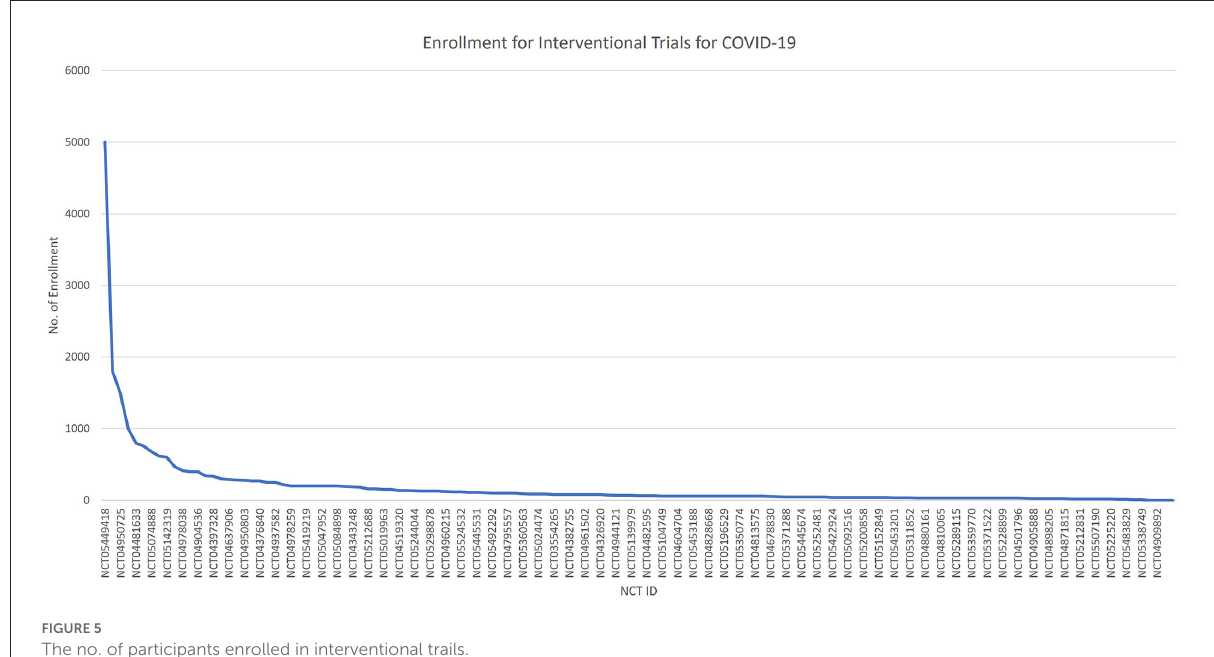
FIGURE5 The no. of participants enrolled in interventional trails.